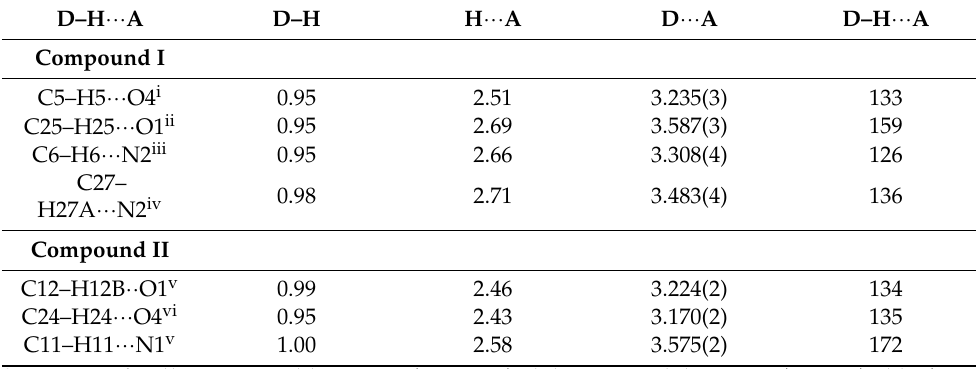
Table 1. Hydrogen bond geometry (Å, ◦ ) for compound I and II